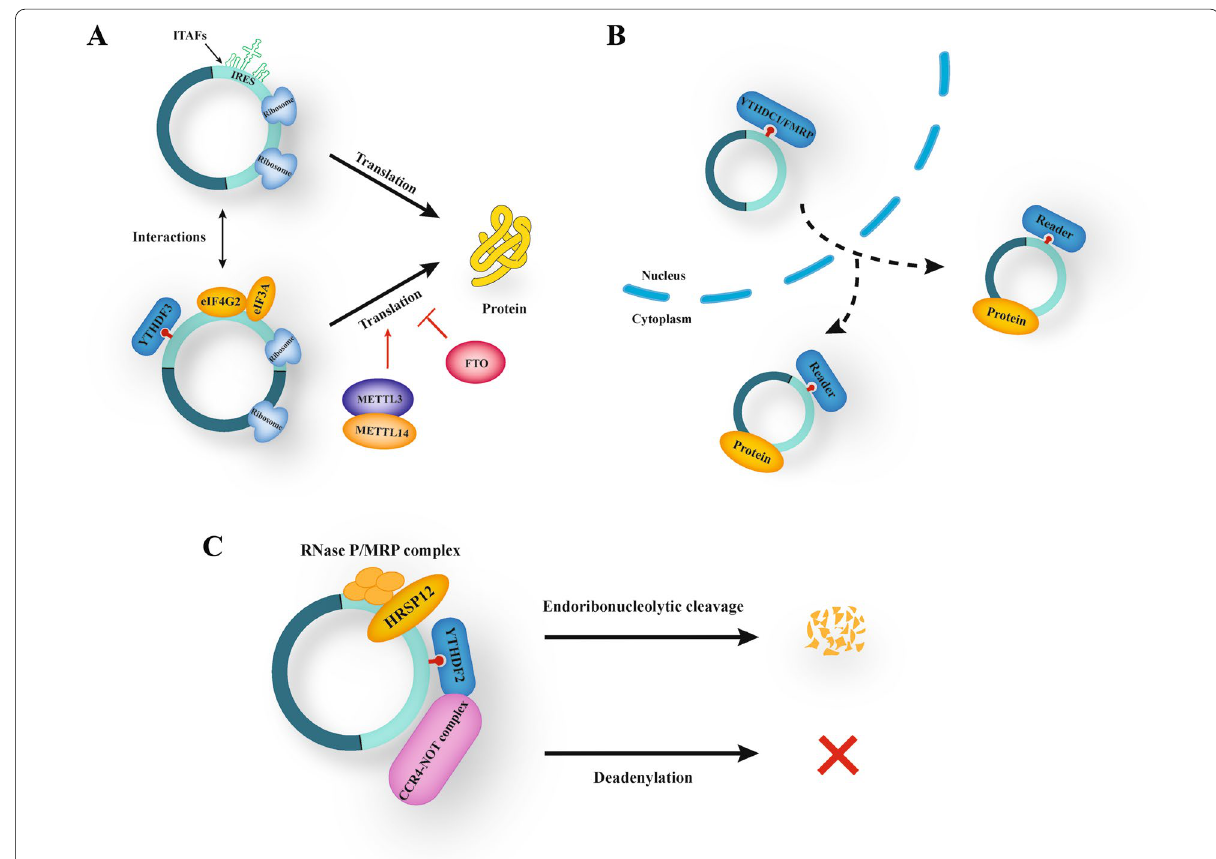
Fig. 3 Role of M 6 A modifications on circRNAs. A M 6 A modification mediates circRNAs translation. M 6 A-driven translation of circRNAs relies on YTHDF3, eIF4G2 and eIF3A. Meanwhile, the process can be enhanced by METTL3/14 and inhibited by FTO. Besides, it is suggested that an interaction may exist between the IRES-driven translation and m 6 A-driven translation. B M 6 A modification mediates circRNAs nucleoplasmic transport. The m 6 A readers, such as YTHDC1 and FMRP, could induce the nuclear and cytoplasmic transport of circRNAs. C M 6 A